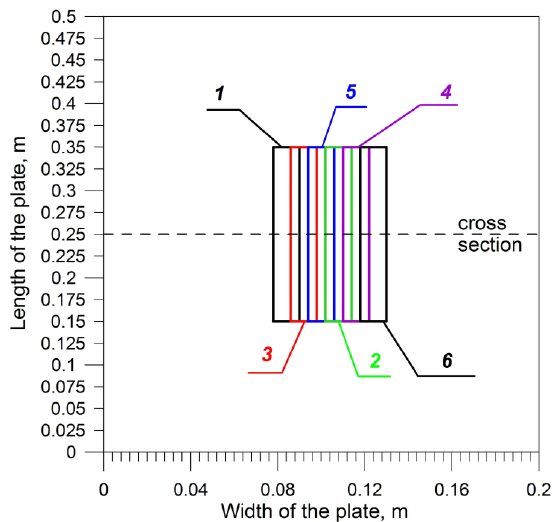
Figure 18. The scheme of GMAW surfaced area on the top surface of the plate with alternate sequence of the weld padding. Appl. Sci. 2017 , 7 , x